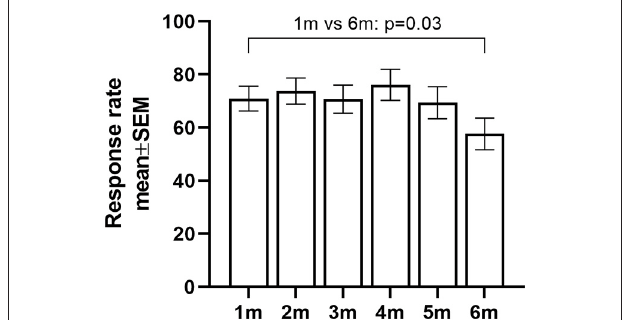
FIGURE 1 | Percentage of response rate to the medication question over time [defined as months (m)]; pooled data from intervention and sham group. Data expressed as marginal means and